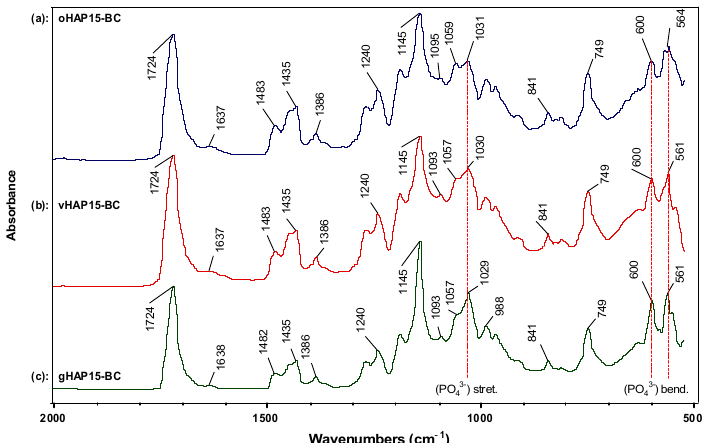
Figure 10. FTIR spectra of bone cements modified with 15 wt.% of oHAP, vHAP and gHAP, labeled as ( a ): oHAP15-BC, ( b ): vHAP15-BC and ( c ): gHAP15-BC, respectively.